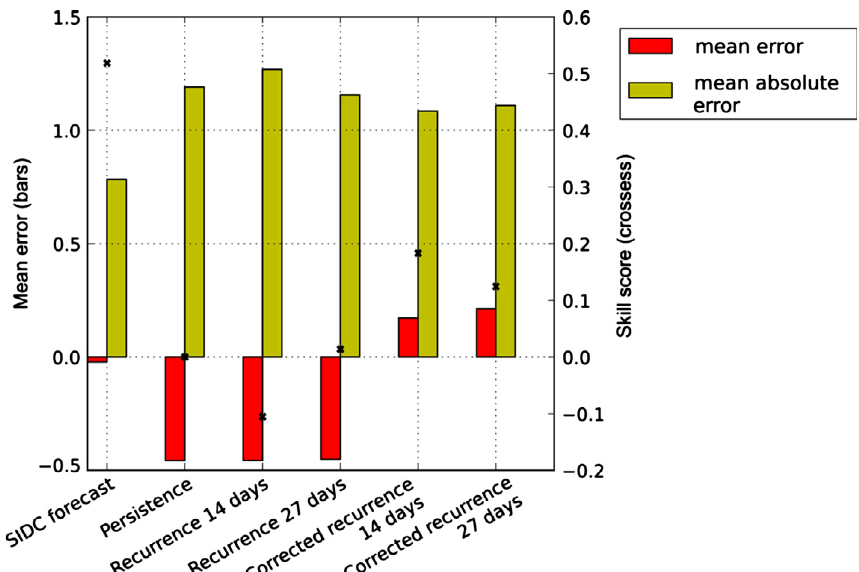
Fig. 7. Mean size of errors for the forecast of the local K -index. The plots include results for the SIDC forecast and the numerical models persistence, recurrence and corrected recurrence of 14 and 27 days. The left vertical axis displays the error (colored bars) and the right vertical axis the skill score (crosses) for each of the forecast models with respect to the persistence model as reference model. The mean errors (red bars, Eq. (3)) as well as the mean absolute errors (green bars, Eq. (4)) are displayed.